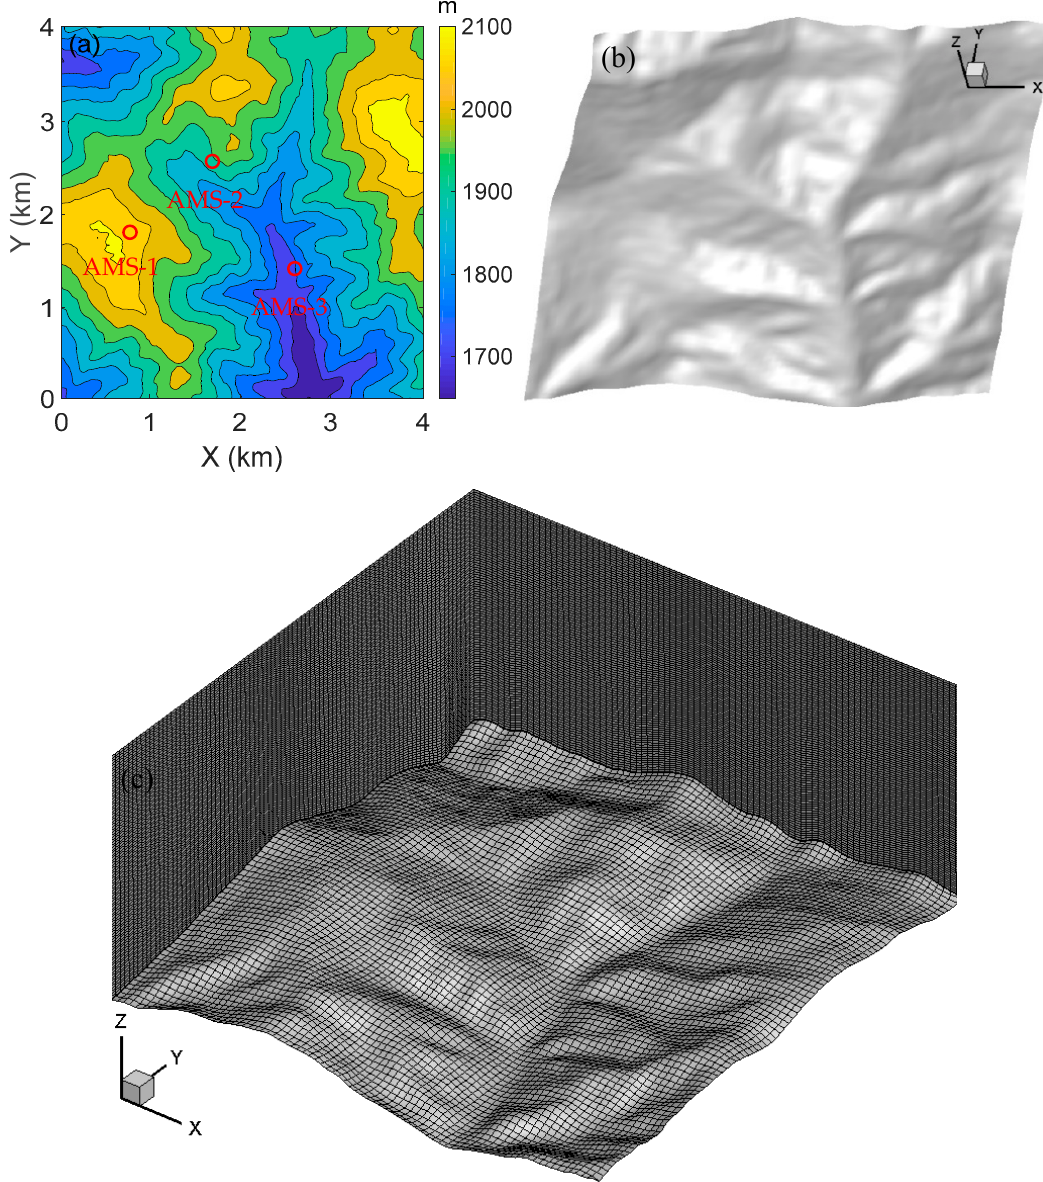
Figure 2. Diagrams of the CFD configuration based on the Advanced Spaceborne Thermal Emission and Reflection Radiometer (ASTER) Global Digital Elevation Model (GDEM): ( a ) Topographic distribution and the distribution of the automatic meteorological stations (AMSs) (red dots) in the mountain region; ( b ) 3D terrain model; ( c ) CFD domain discretized with hexahedral grids.